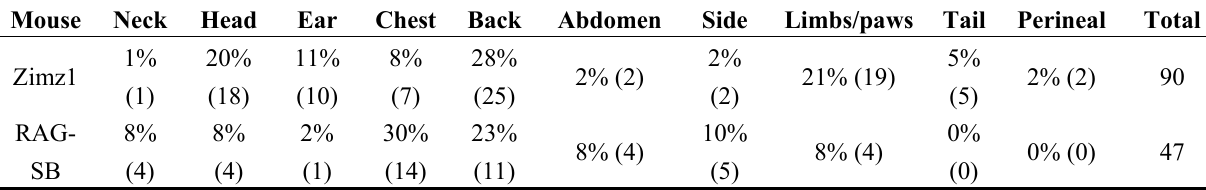
Table 1. Distribution of keratoacanthomas (KA) tumors on Zimz1 and RAG-SB mice expressed as a percentage of the total and, in parentheses, the total number